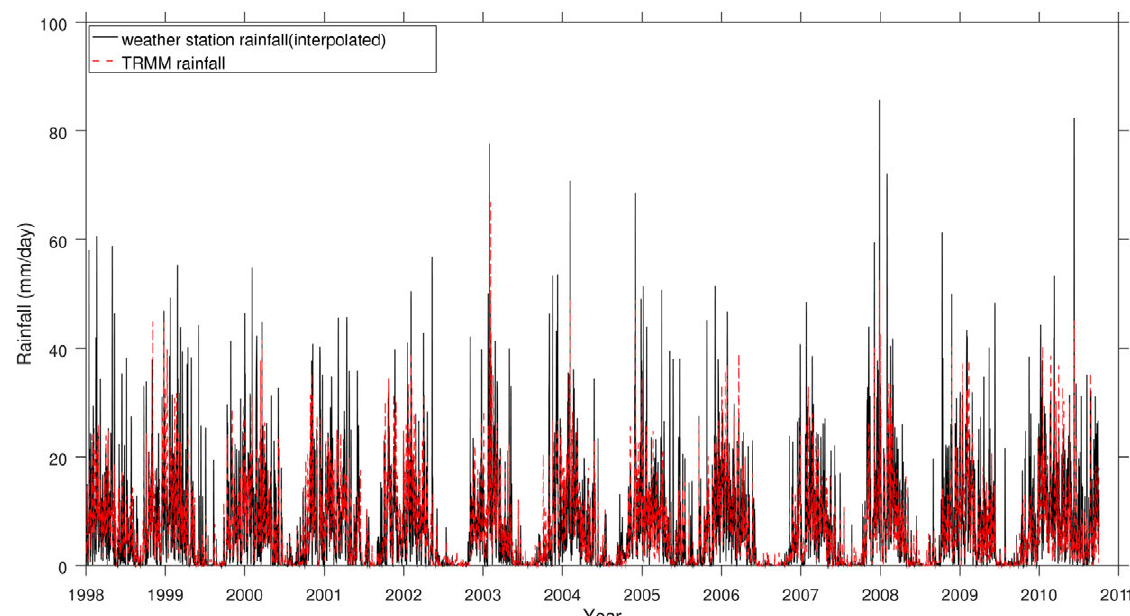
Fig. 10. Long term plot of precipitation from TRMM and interpolated weather station precipitation data.